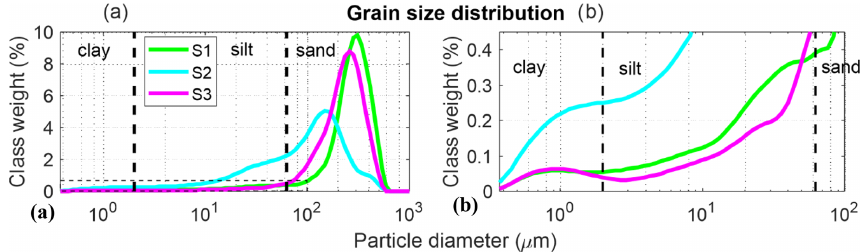
Figure 6. (a) Grain size distribution. (b) Magnified grain size distribution in the fine-grain size region plotted for sandstones S1 (green), S2 (blue) and S3 (purple). S1 and S3 have a unimodal distribution and are moderately sorted with a small skewness tail. Sample S2 has a multi-modal distribution and is poorly